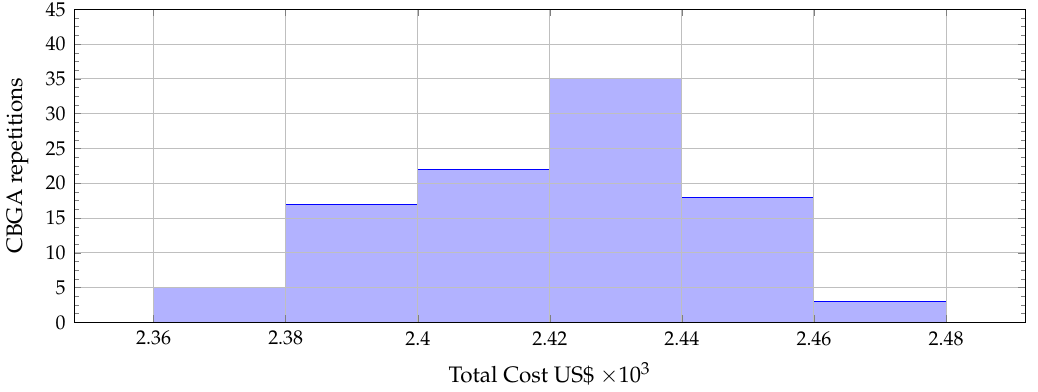
Figure 10. Behavior of the solutions in the 33-node system after 100 repetitions.